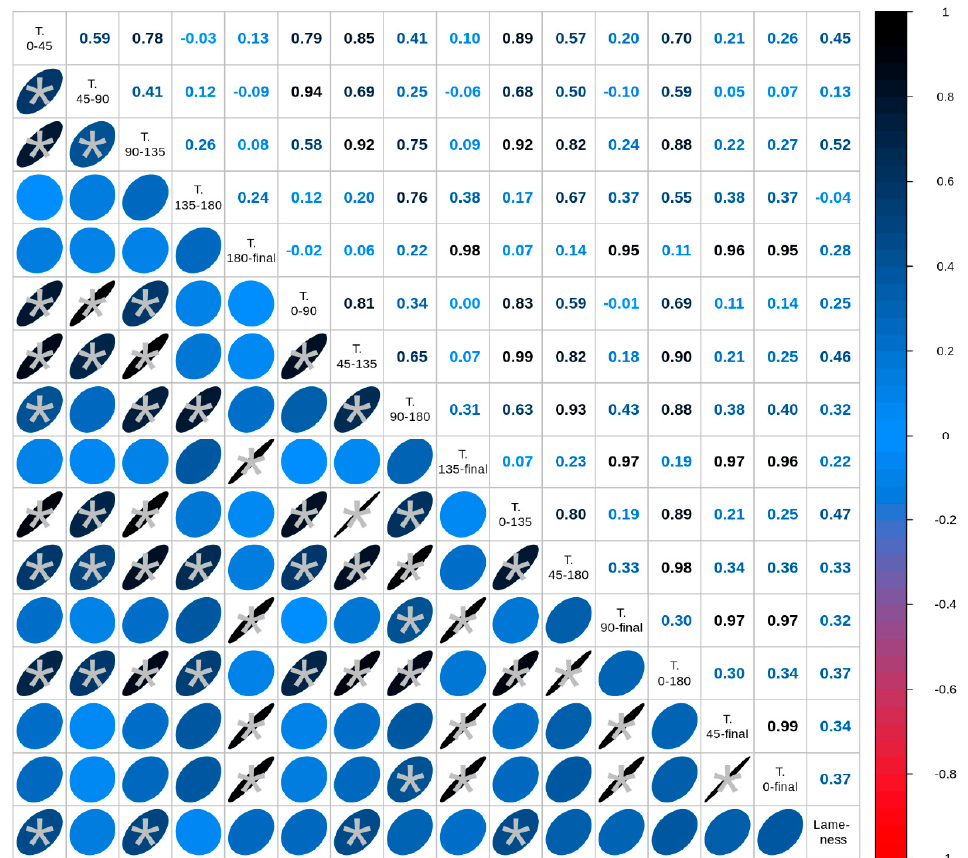
N a,b denote significant differences ( p < 0.001).